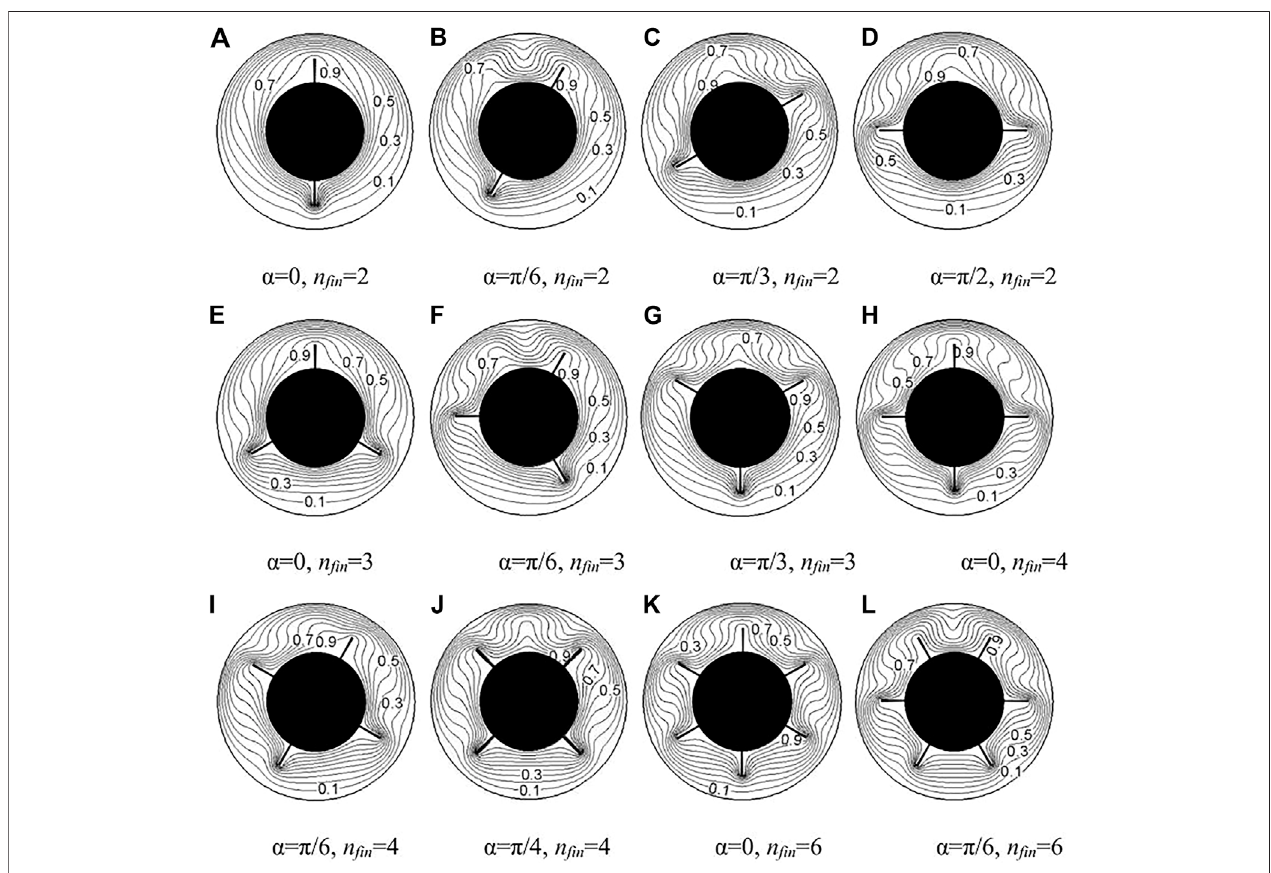
FIGURE 4 | Temperature fi elds with different fi n numbers and positions for Ra (cid:1) 5 × 10 3 . (A) α (cid:1) 0, n fi n (cid:1) 2 (B) α (cid:1) π /6, n fi n (cid:1) 2 (C) α (cid:1) π /3, n fi n (cid:1) 2 (D) α (cid:1) π /2, n fi n (cid:1) 2 (E) α (cid:1) 0, n fi n (cid:1) 3 (F) α (cid:1) π /6, n fi n (cid:1) 3 (G) α (cid:1) π /3, n fi n (cid:1) 3 (H) α (cid:1) 0, n fi n (cid:1) 4 (I) α (cid:1) π /6, n fi n (cid:1) 4 (J) α (cid:1) π /4, n fi n (cid:1) 4 (K) α (cid:1) 0, n fi n (cid:1) 6 (L) α (cid:1) π /6, n fi n (cid:1) 6.